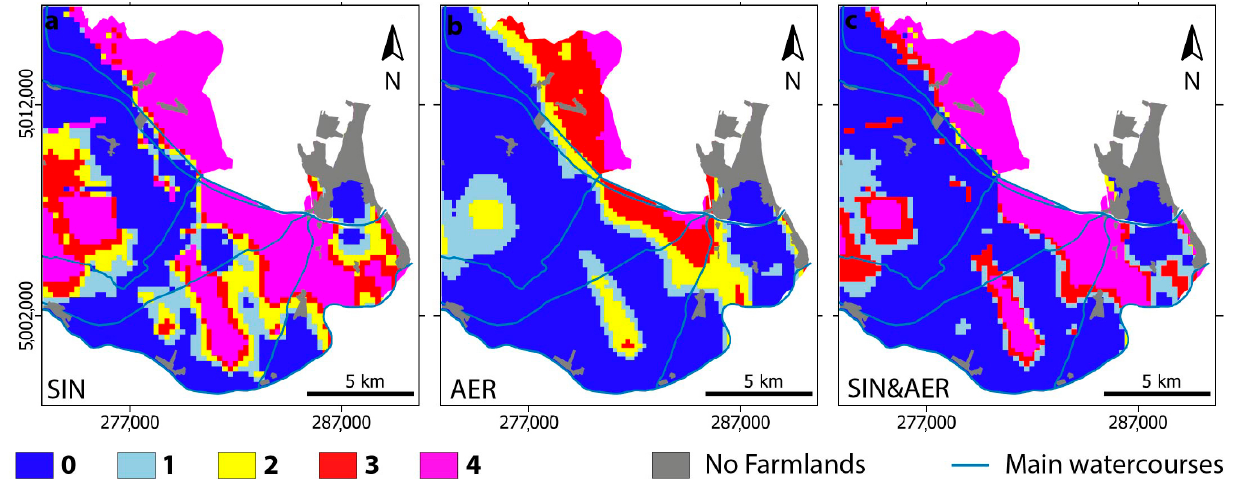
Figure 7. Classification of the hazard layers: ( a ) freshwater–saltwater interface depth (SIN), ( b ) average electrical resistivity (AER), and ( c ) freshwater–saltwater interface depth (SIN) combined with average electrical resistivity (SIN&AER). Scores from 0 to 4 identify low-to-high contributions to vulnerability. Coordinate system: UTM33, WGS84.